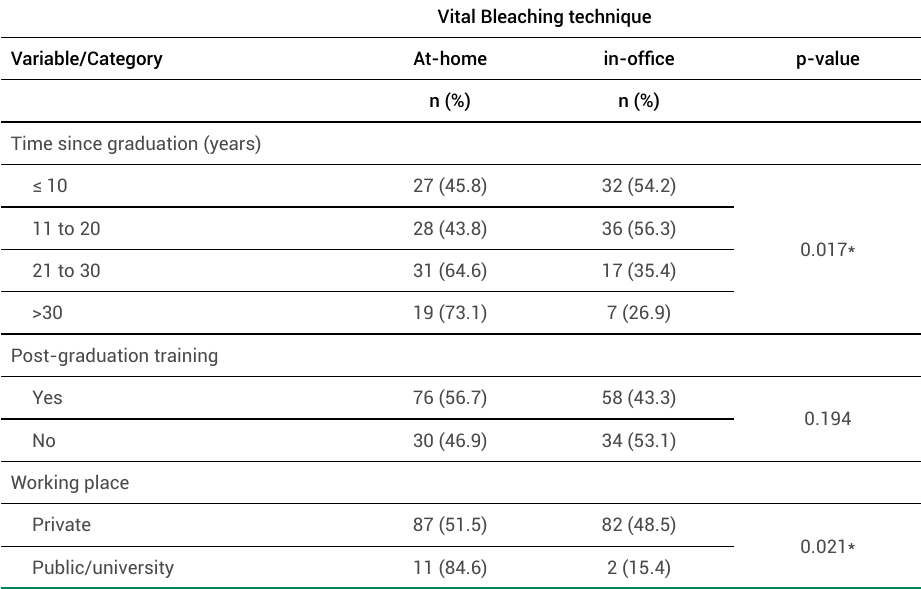
Table 2. Association between the choice of the vital bleaching technique (at-home or in-office) and the independent variables Vital Bleaching